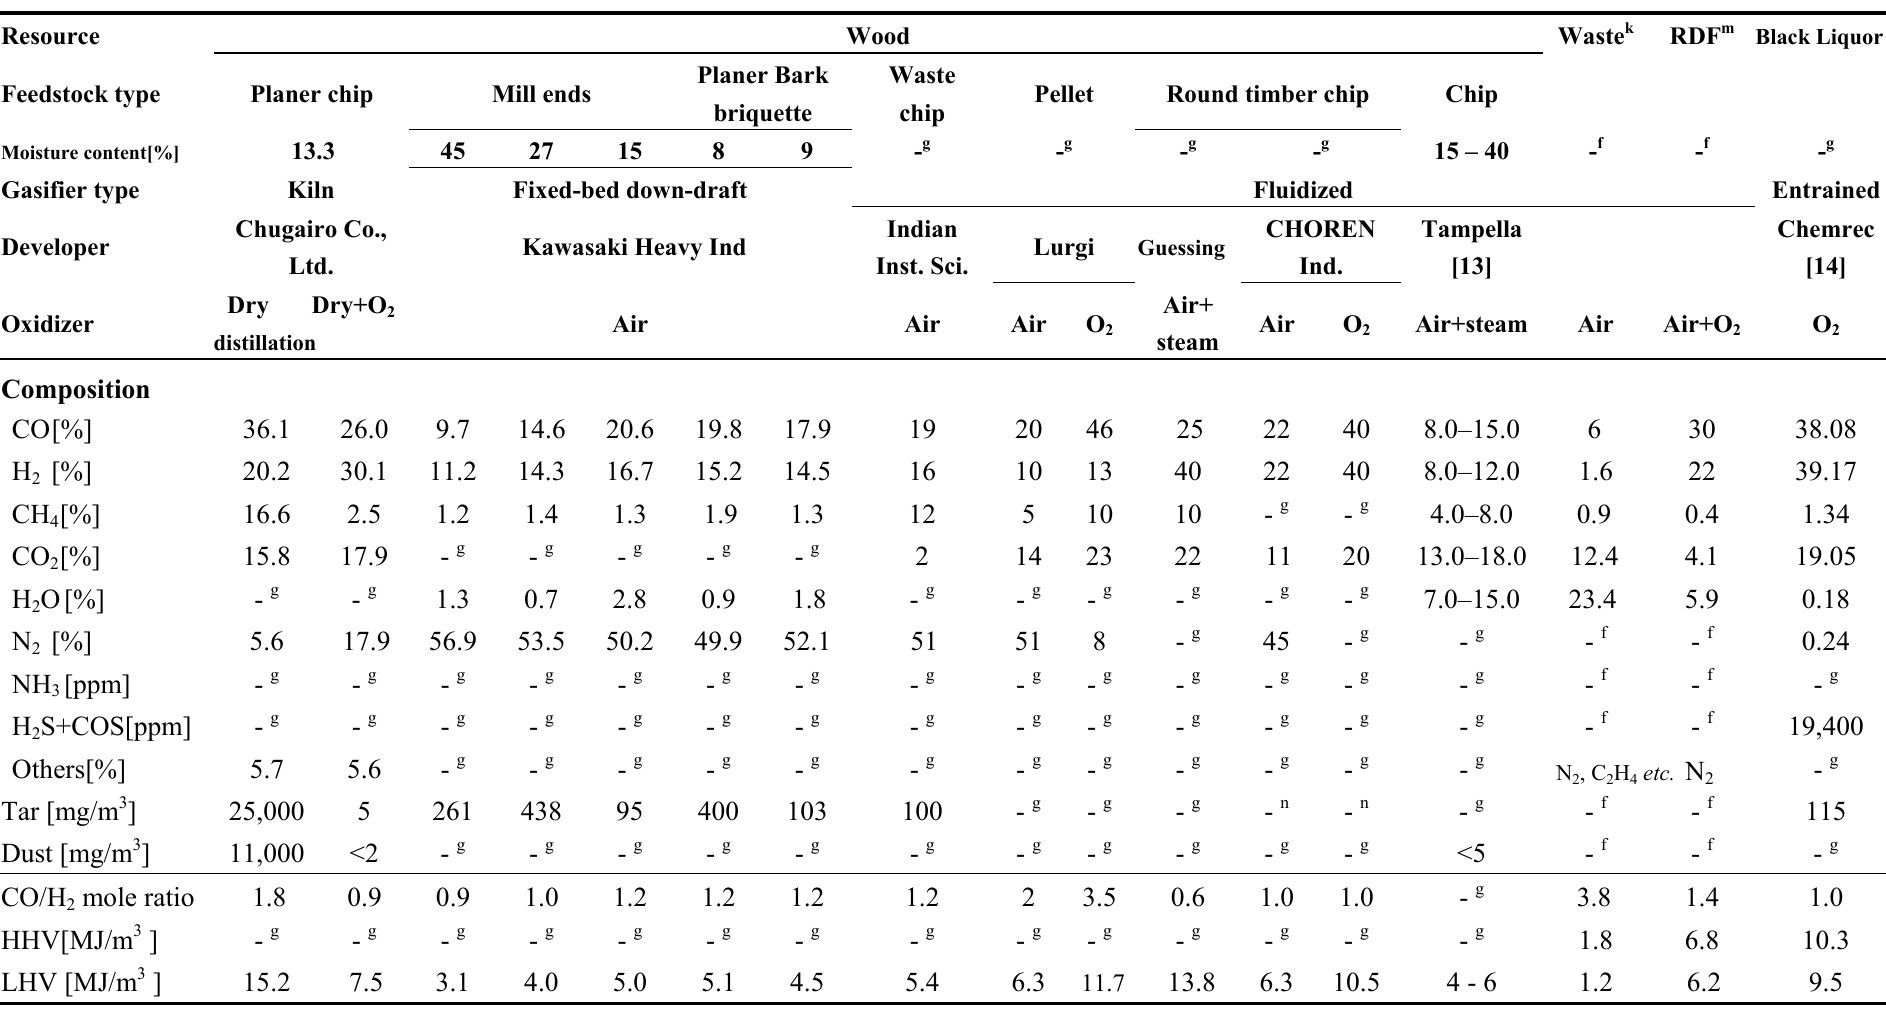
Table 2. Typical compositions of gasified fuels from non-fossil